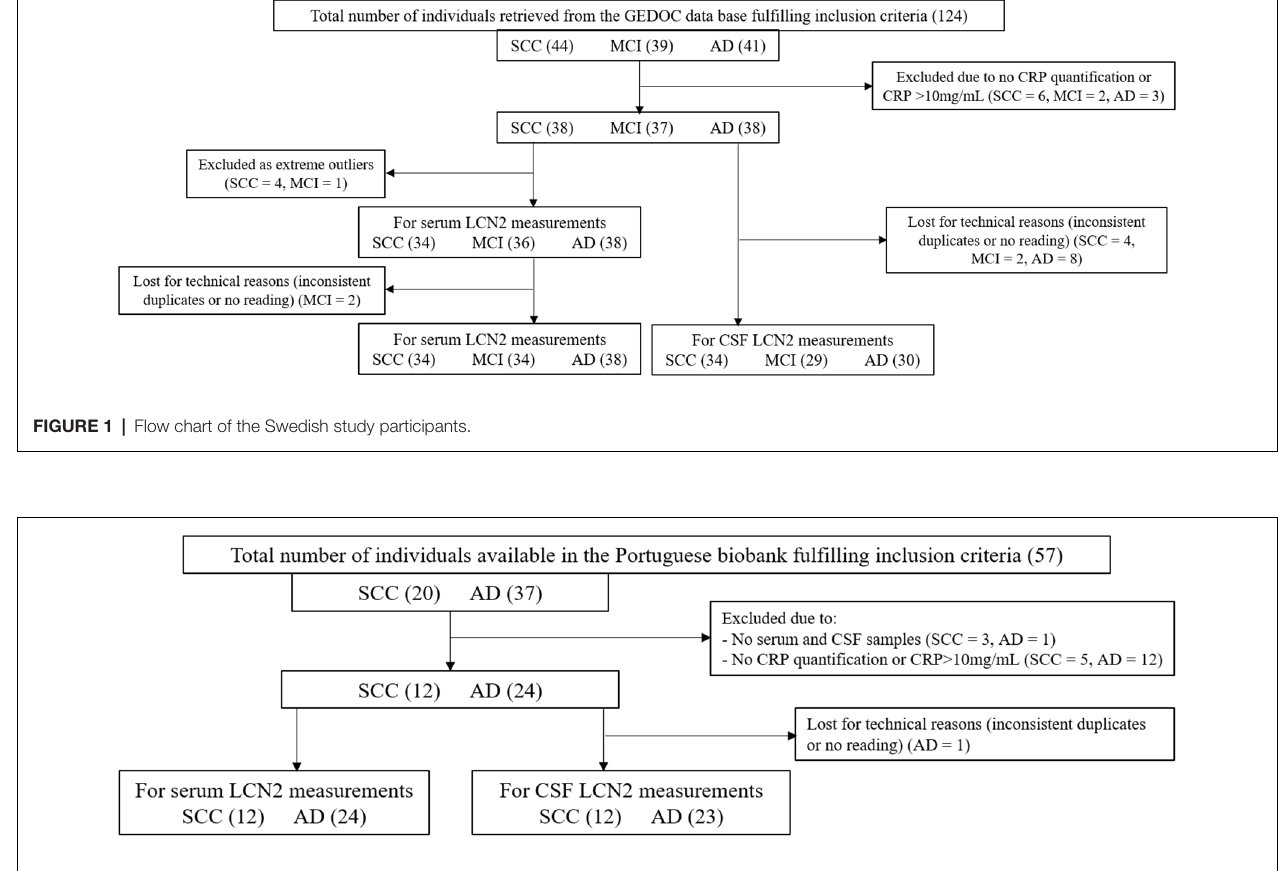
FIGURE 2 | Flow chart of the Portuguese study